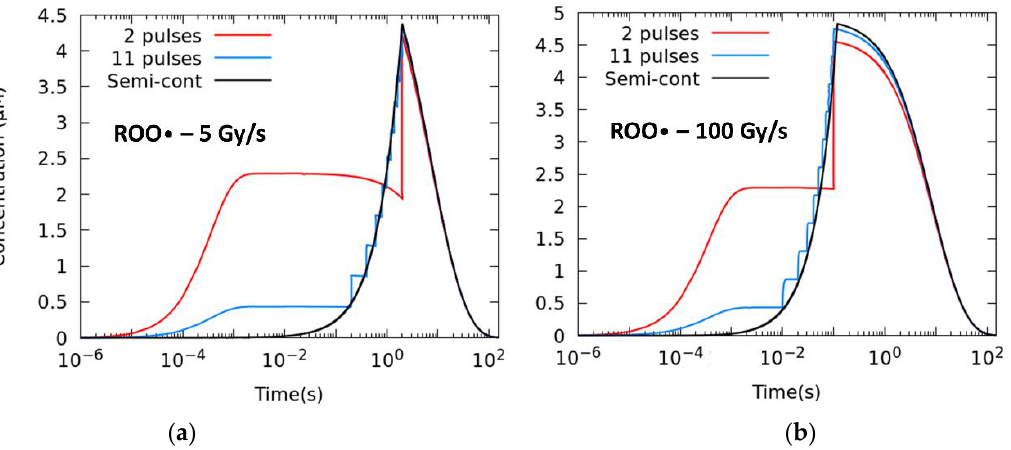
Figure 3. Time evolution of the ROO• radical for different degrees of pulsatility. The simulations correspond to a total dose of 10 Gy with 1.8 μs width pulses and mean dose rates of ( a ) 5 Gy/s and ( b ) 100 Gy/s.